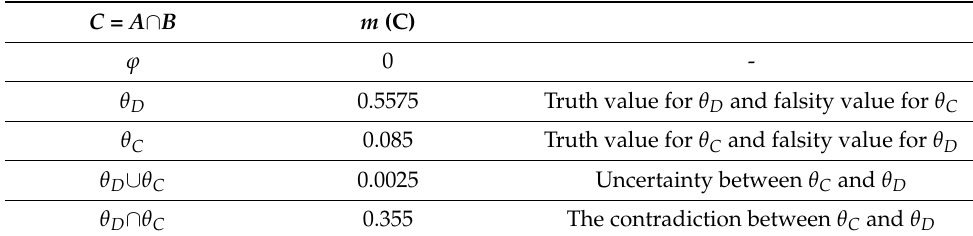
Table 3. The experimental data after using Equation (6).